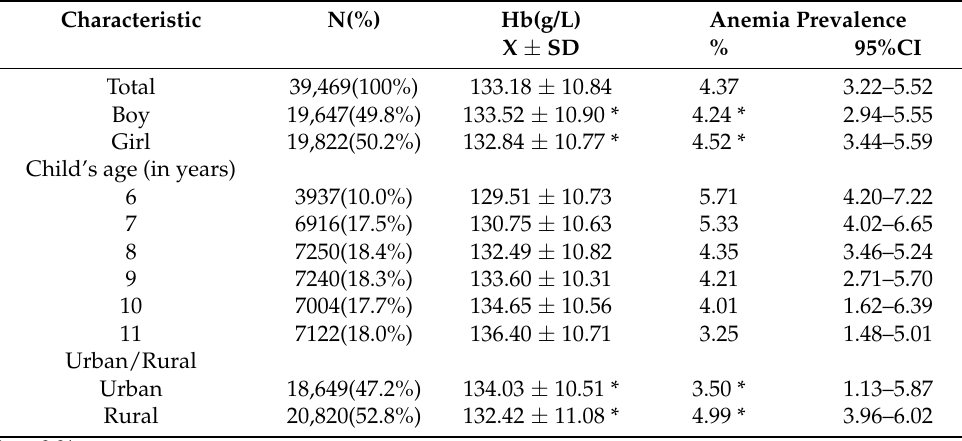
Table 1. Hemoglobin and Anemia status of SAC in primary